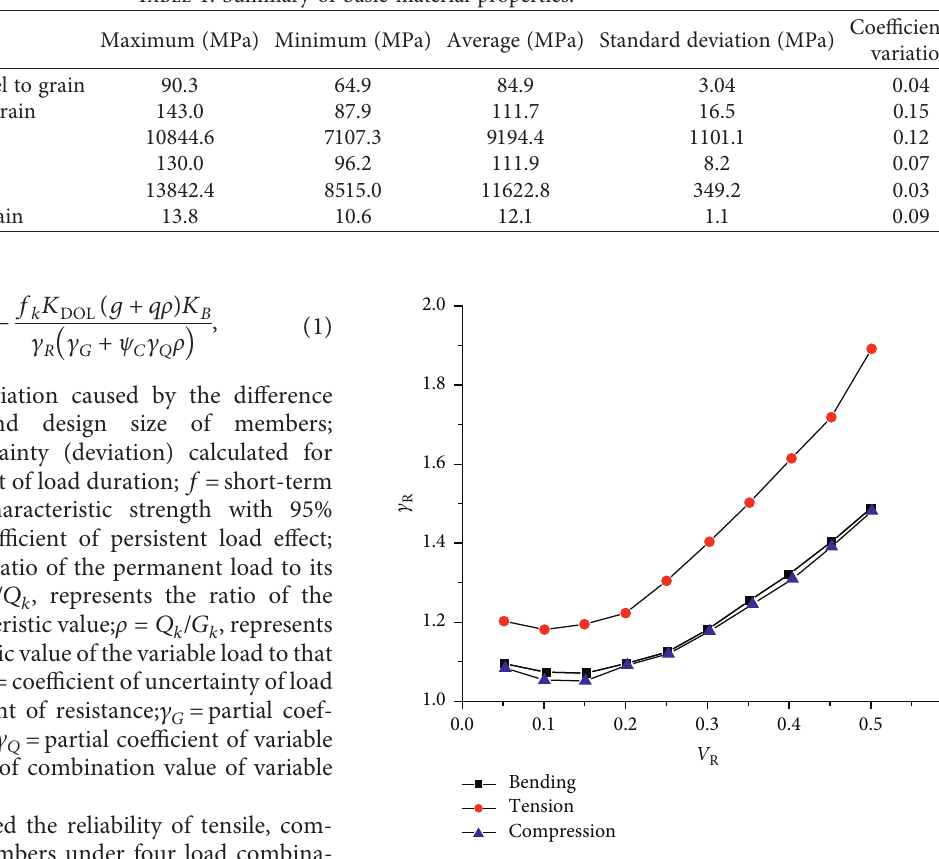
Figure 7: Benchmark